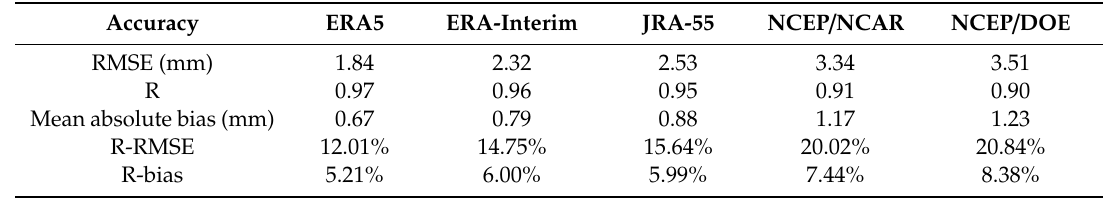
Table 2. R, mean absolute bias, RMSE, R-bias and R-RMSE for ERA5, ERA-Interim, JRA-55,